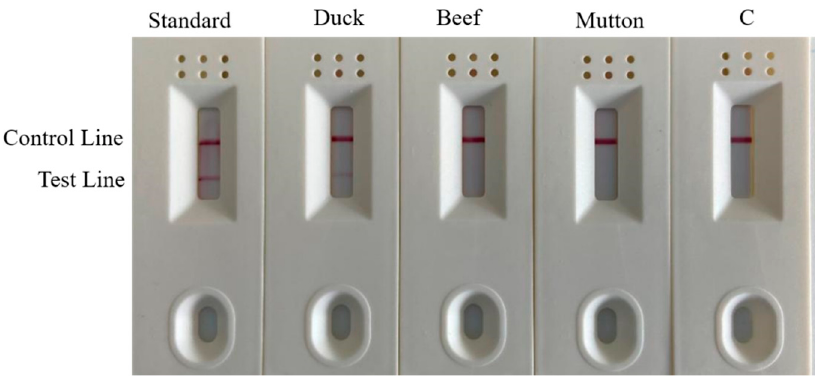
Figure 10. Strip test results. Lane C is the blank